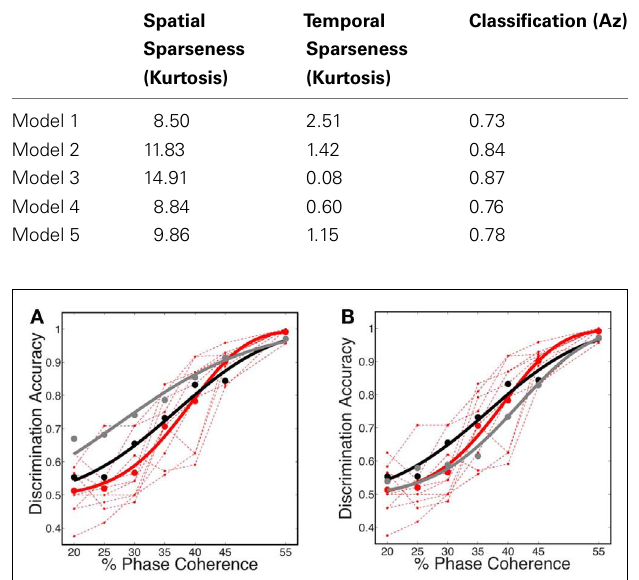
FIGURE 9 | Comparison of several decoding strategies. (A) Two decoding strategies: (black) train and test at each coherence independently, D = 3.19, P = 0.53; (gray) train at the highest coherence and test at each coherence, D = 12.88, P = 0.01. Both are trained as sparse decoders. (B) Sparse and non-sparse decoding strategies: (black) sparse decoder, D = 3.19, P = 0.53; (gray) non-sparse decoder each with the same amount of regularization, D = 3.66, P = 0.45. Both are trained on each coherence independently. Also shown are (dashed red lines) the psychophysical performance of 10 human subjects; (solid red curve) the group psychometric curve across 10 subjects.